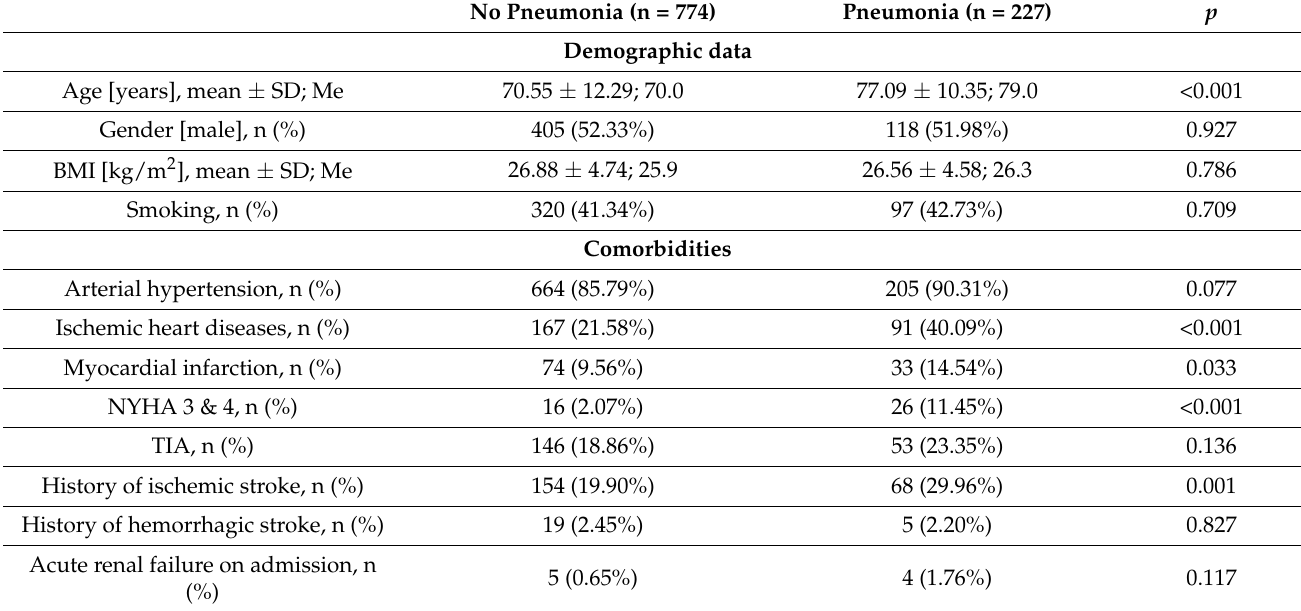
Table 1. Demographic data and comorbidities for the admitted ischemic stroke patients. No Pneumonia (n =